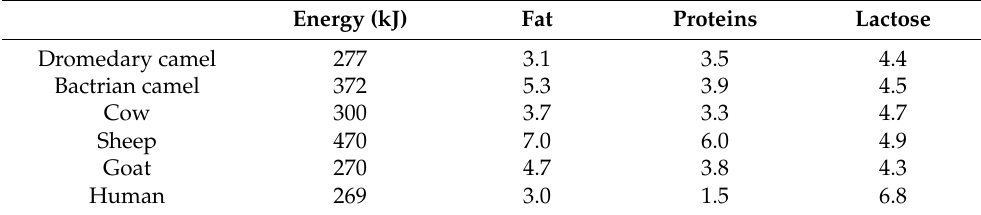
Table 1. Milk chemical composition and energy in mammalian species (g/100 g). Energy (kJ) Fat Proteins Lactose Dromedary